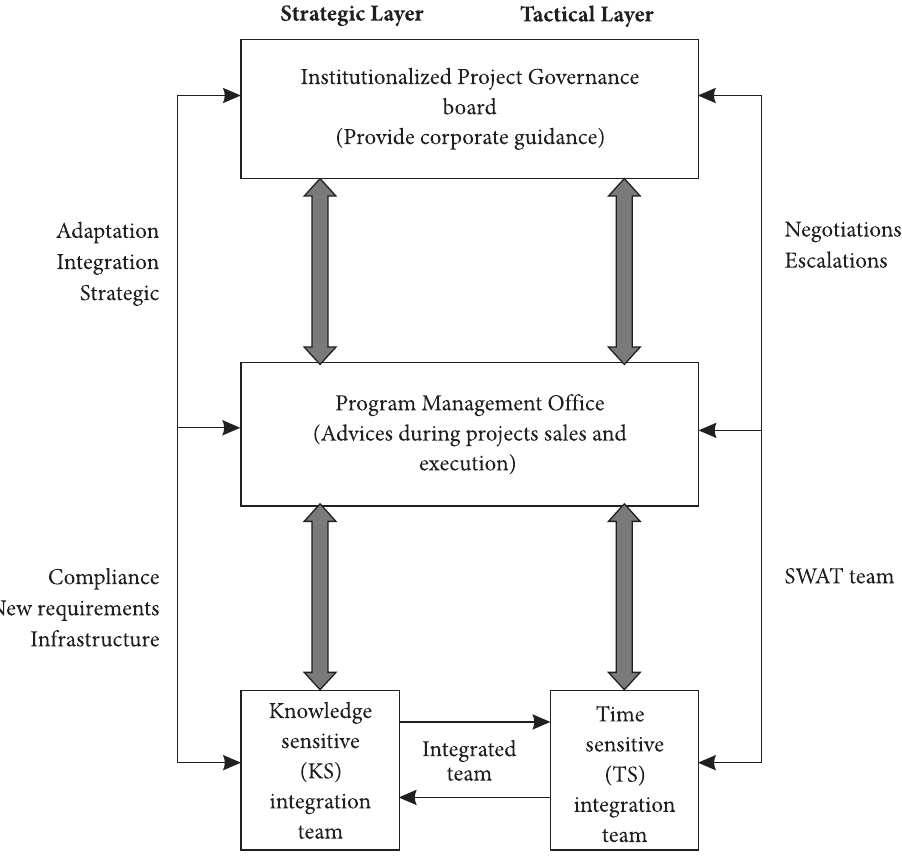
Fig. 3. Multi-layer proposed governance